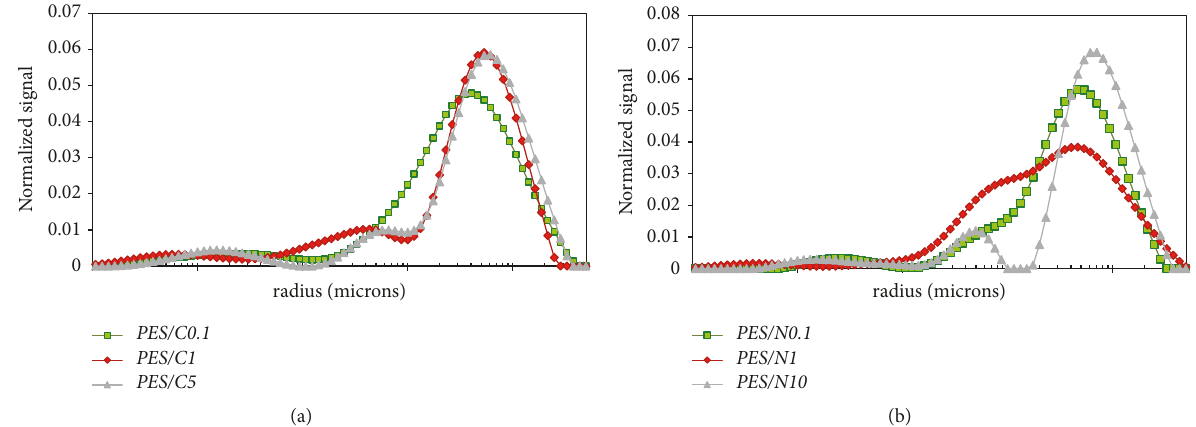
Figure 7: Pore size distribution of PES produced with Cyrene (cid:2) (a) and NMP (b) using NMR.